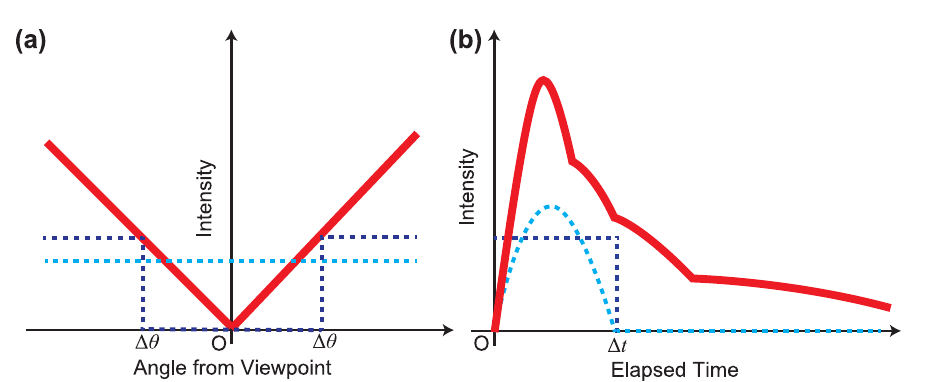
Fig 6. Schematic diagram of compensation function. (a) Spatially dependent function. (b) Temporally dependent function. The red line denotes the function used in this experiment, and the dark and light blue dashed lines denote the function used in Experiments 1 and 2,